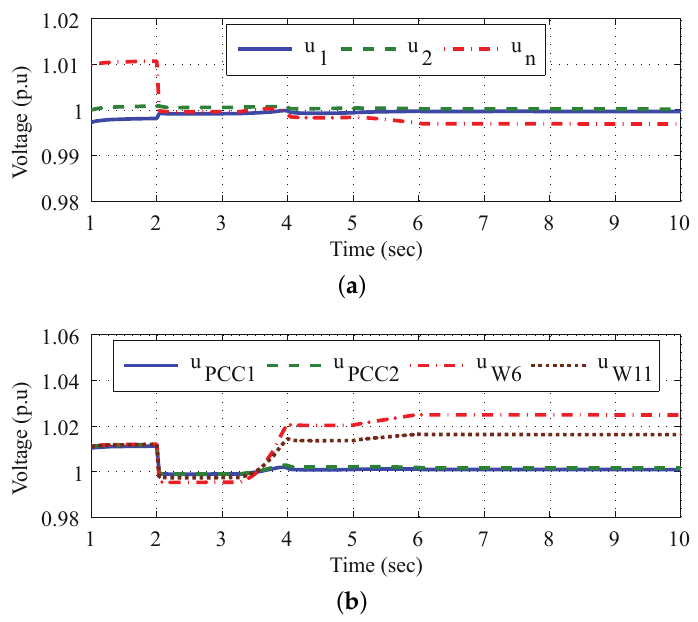
Figure 12. Voltage responses of ( a ) converter substation busbars and ( b ) wind power plant busbars.